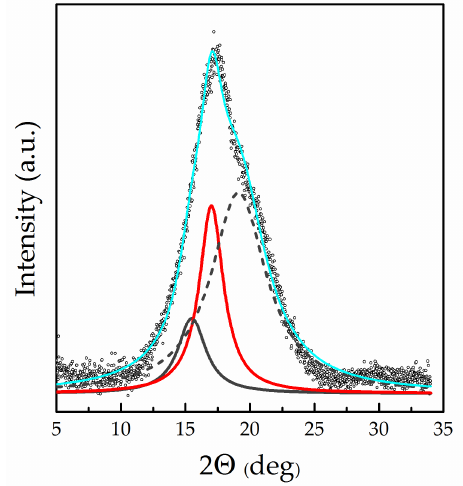
Figure 9. Decomposition of X-ray diffraction profile near (100) Bregg peak for Li-Nafion saturated with EC/SL mixture with ω(SL) = 0.2 at the mixing temperature of 25 °C.